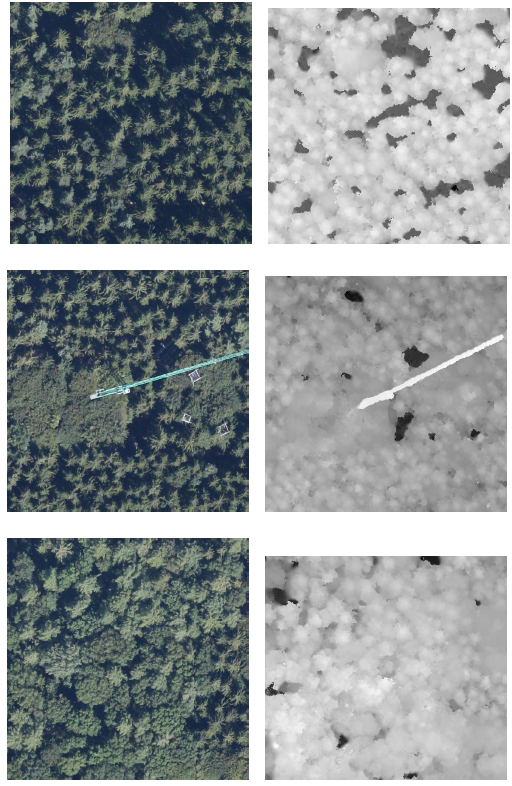
Figure 1. KROOF area: From top to bottom, the near-NADIR image / DSM of the coniferous, mixed and deciduous plots for the 3K-NIR 2016 dataset is shown in the left / right